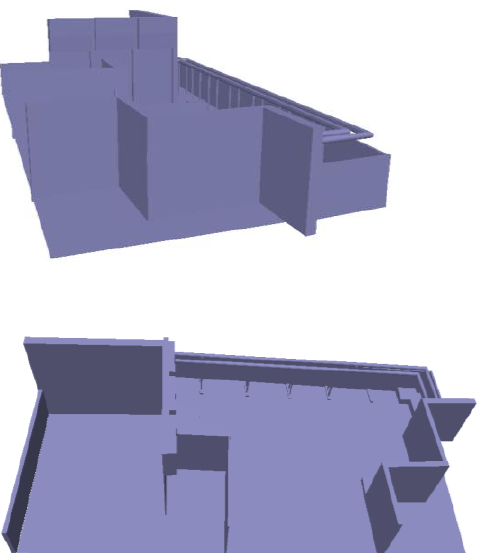
Figure 3. 3D Model of the GIL